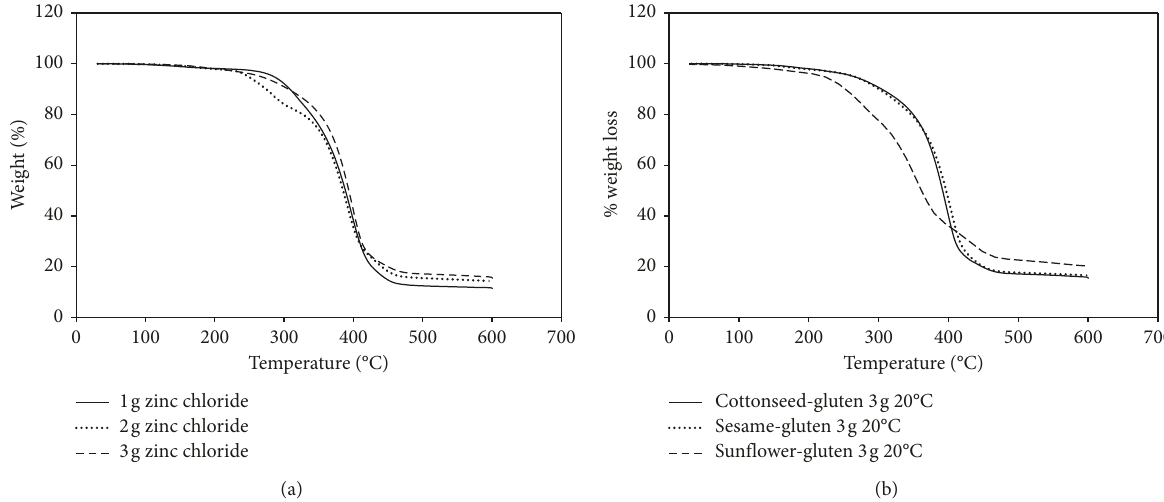
Figure 6: (a) TGA profile of epoxydized cottonseed oil crosslinked with vital gluten at 1, 2, and 3% zinc chloride heated at 20 ° C/min; (b) epoxy resin TGA thermograms of sunflower, cottonseed, and sesame oil crosslinked with gluten at 3% zinc chloride and heated at 20 ° C/min.